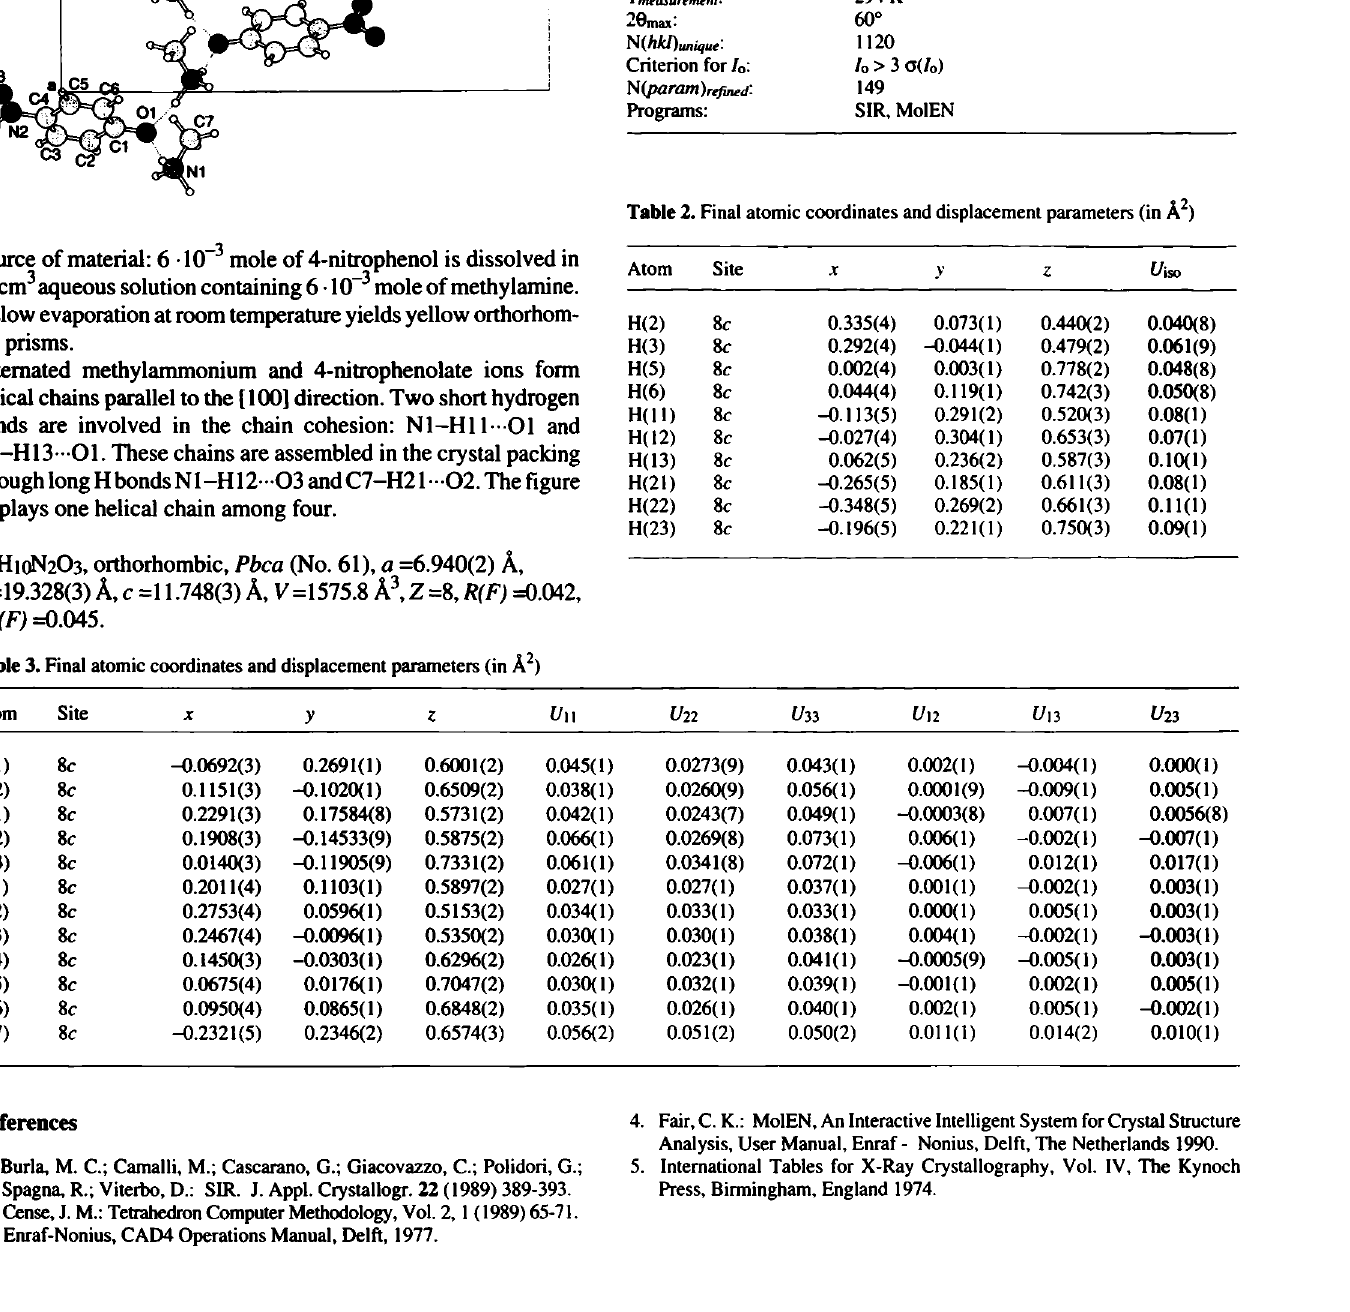
Table 1. Parameters used for the X-ray data collection